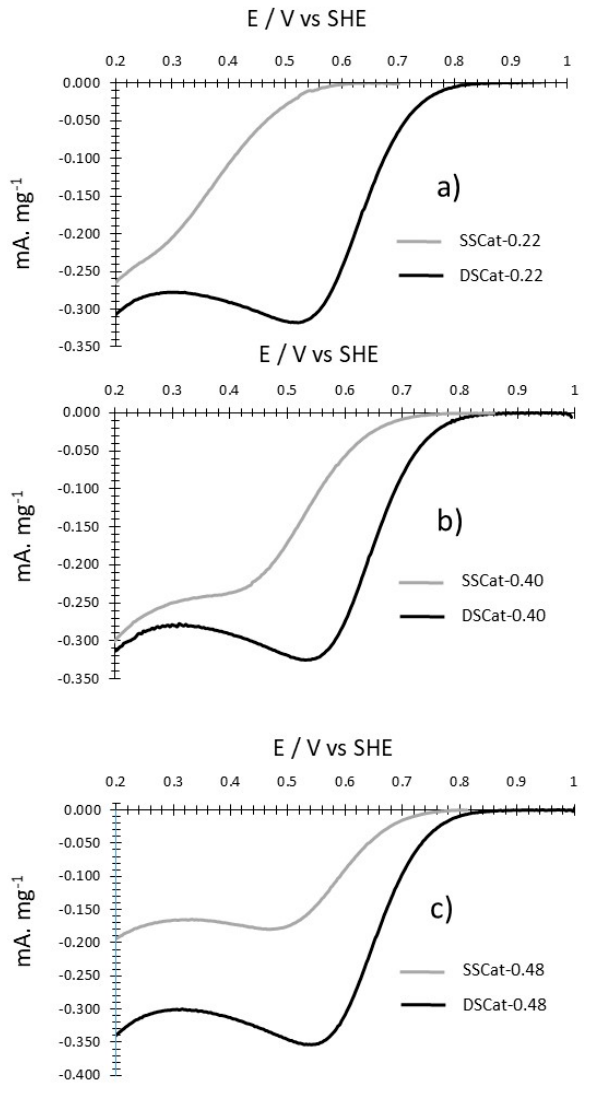
Figure 6. Comparison of SSCat and DSCat background corrected oxygen reduction Cyclic Voltammetry (CVs) recorded at 5 mV · s − 1 for ( a ) R = 0.22, ( b ) R = 0.40 and ( c ) R = 0.48. HClO 4 1 M.